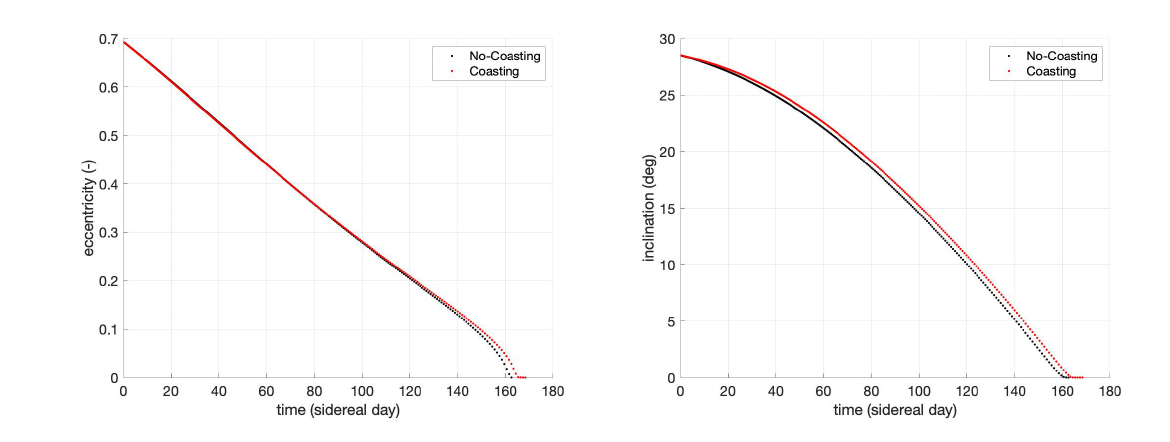
Figure 11. Osculating orbital elements of Sub-GTO to GEO